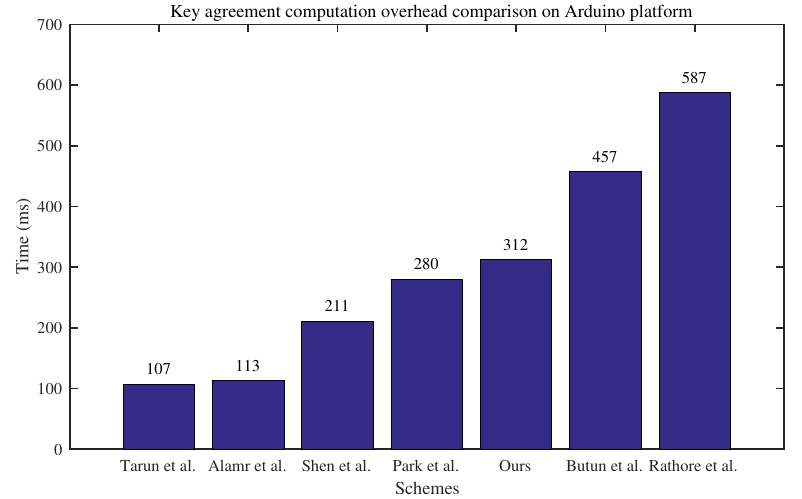
Figure 3. Computation overhead comparison between different protocols on Arduino